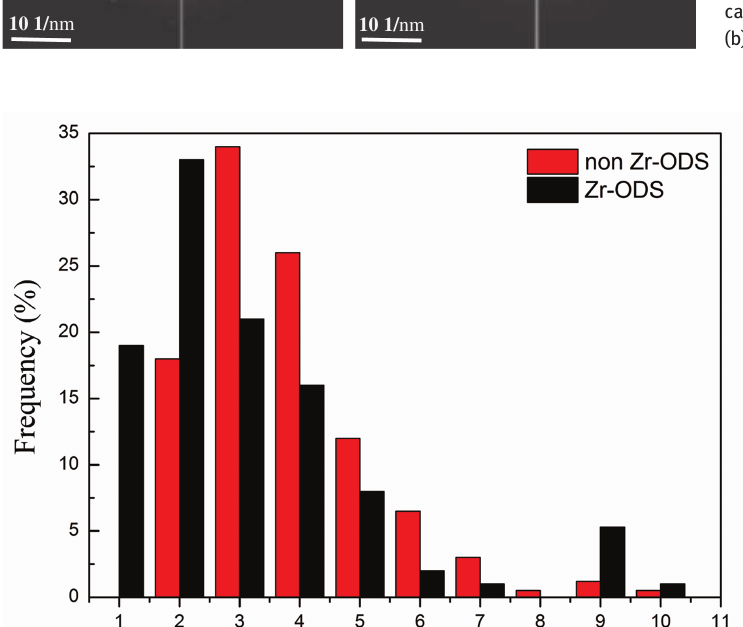
Figure 3: Typical morphology of oxides retrieved in a carbon replica from the ODS steels (a) non Zr-ODS steel (b) Zr-ODS steel.